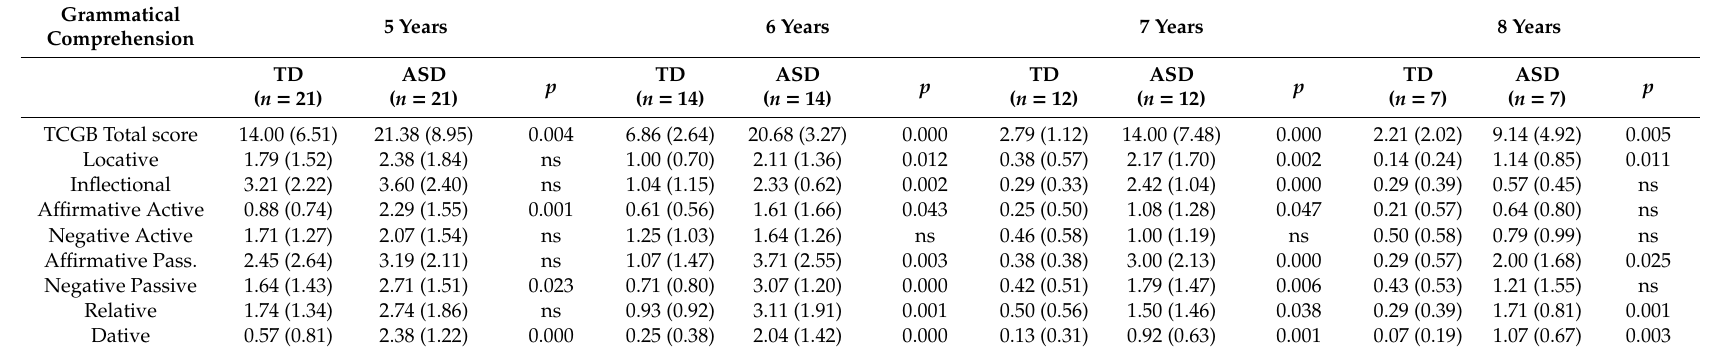
Table 2. Comparison between typically developing (TD) and autism spectrum disorder (ASD) children in the di ff erent age